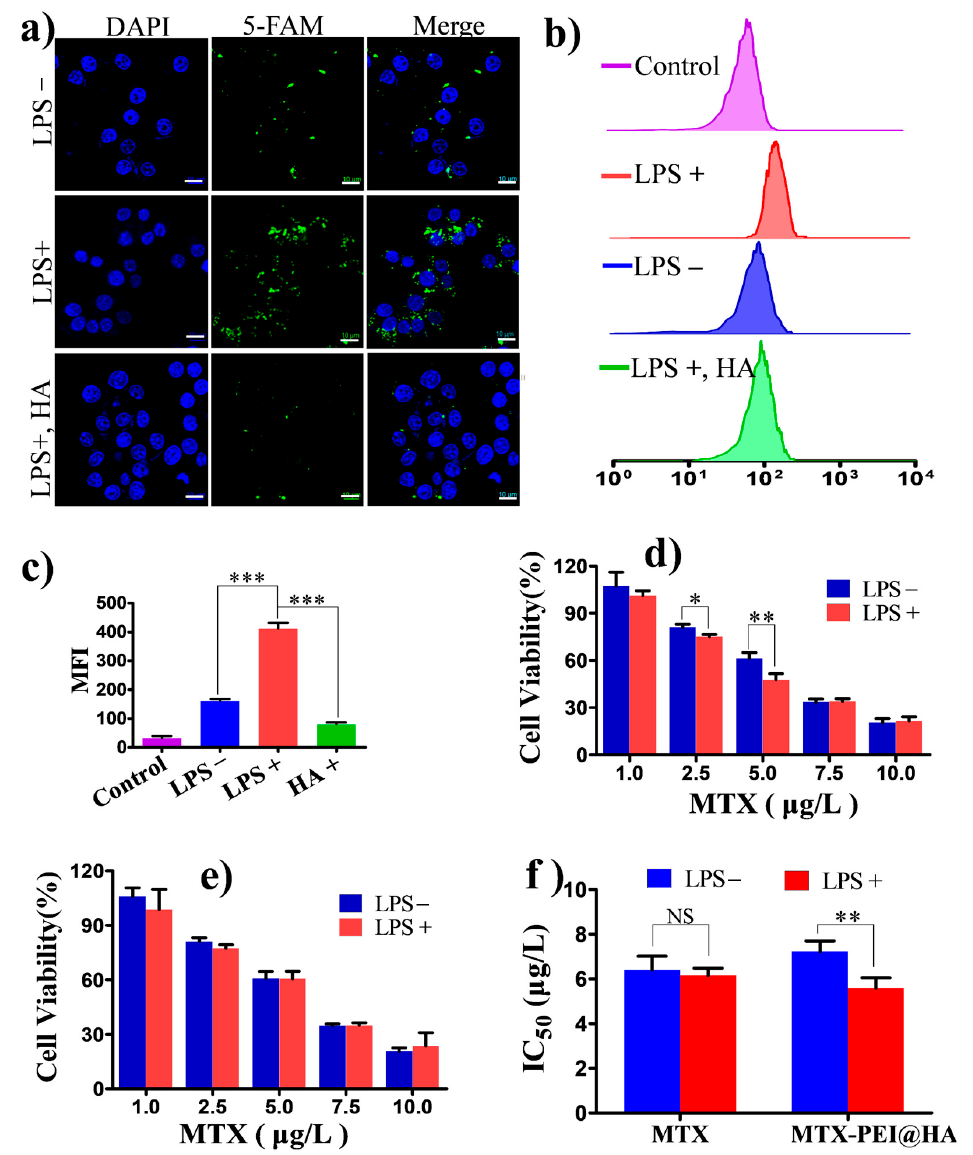
Figure 3. In vitro cellular uptake of MTX-PEI@HA NPs in murine macrophage RAW 264.7 cells. ( a ) Confocal laser scanning microscope images of RAW 264.7 cells treated with 5-carboxyfluorescein (5-FAM)-labeled MTX-PEI@HA NPs. Scale bar = 10 µ m. ( b ) Flow cytometric graphs of fluorescent intensity of 5-FAM in macrophages that treated as listed. ( c ) Quantitation of mean fluorescence intensity (MFI) from ( b ). ( d , e ) Viability of RAW264.7 cells (before and after activation by LPS) after incubation with MTX-PEI@HA NPs for 72 h. ( f ) IC50 values calculated from ( d , e ). * p < 0.05, ** p < 0.01, *** p <